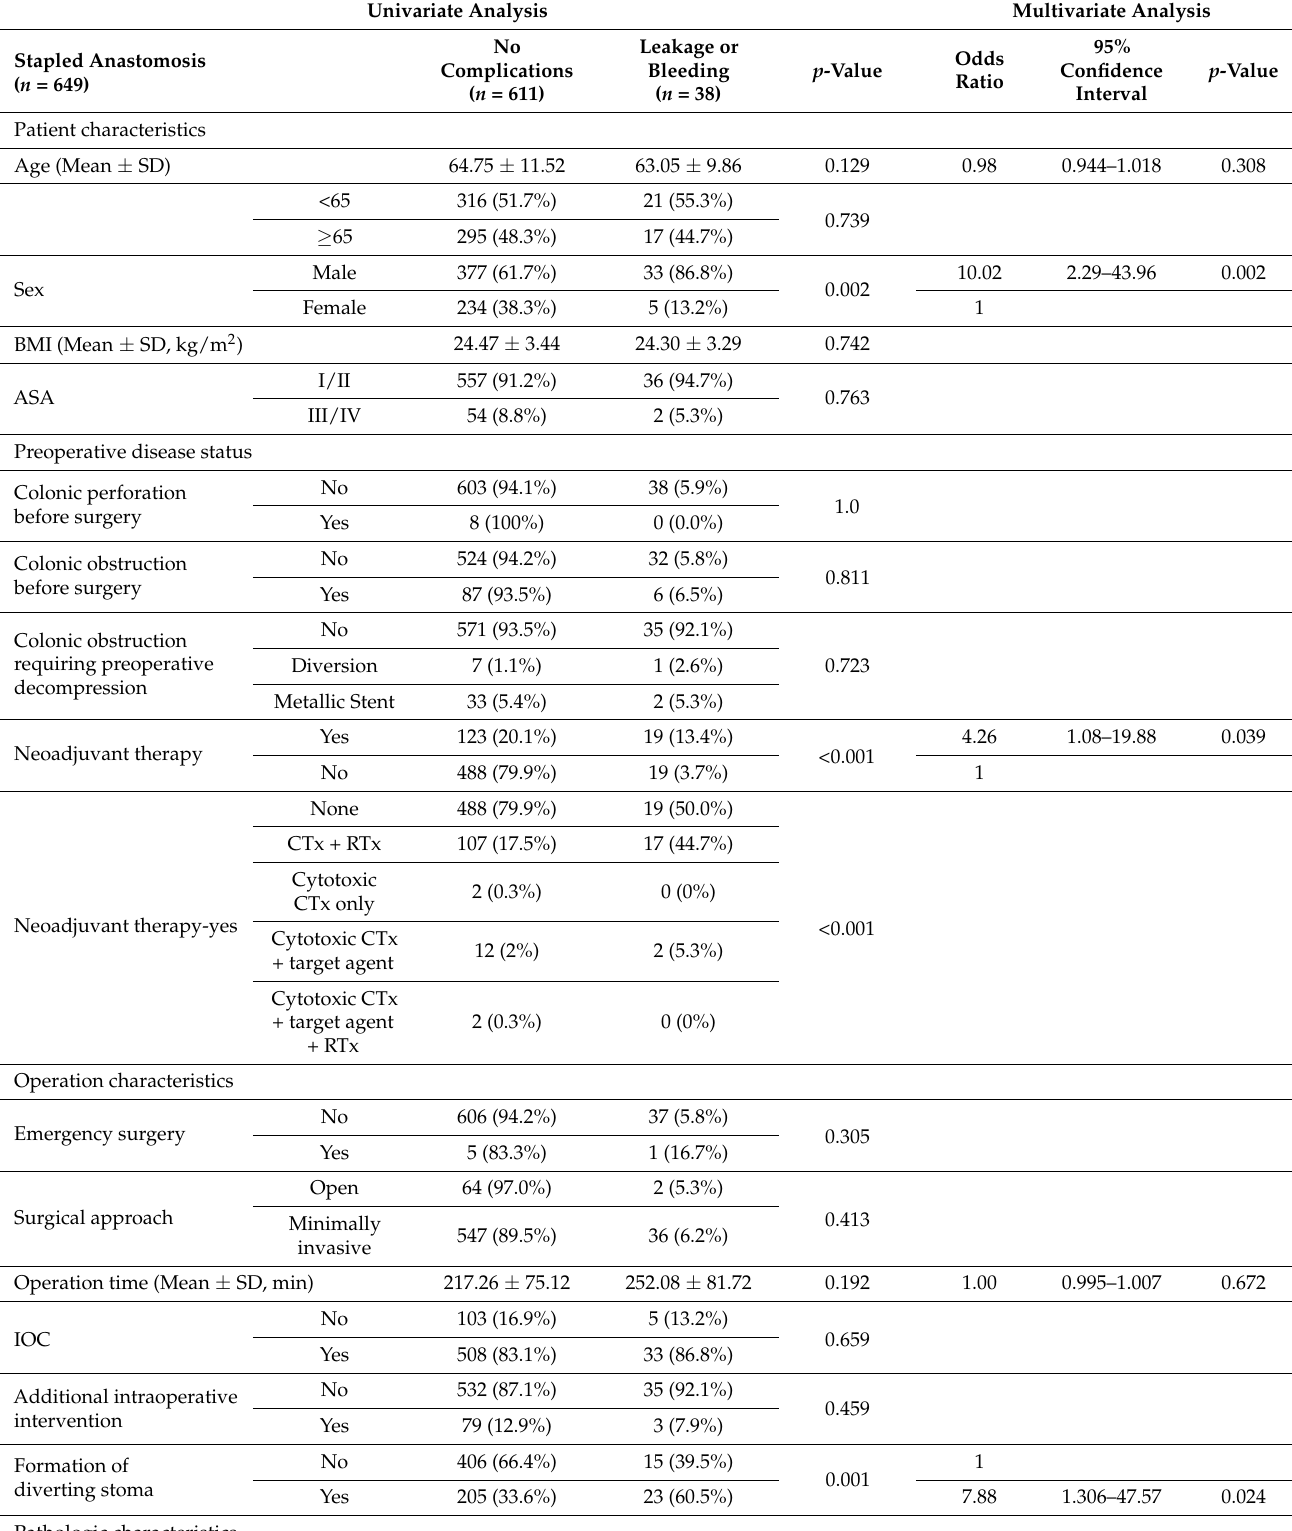
Table 2. Univariate and multivariate analysis comparing patients with and without anastomotic complications in stapled